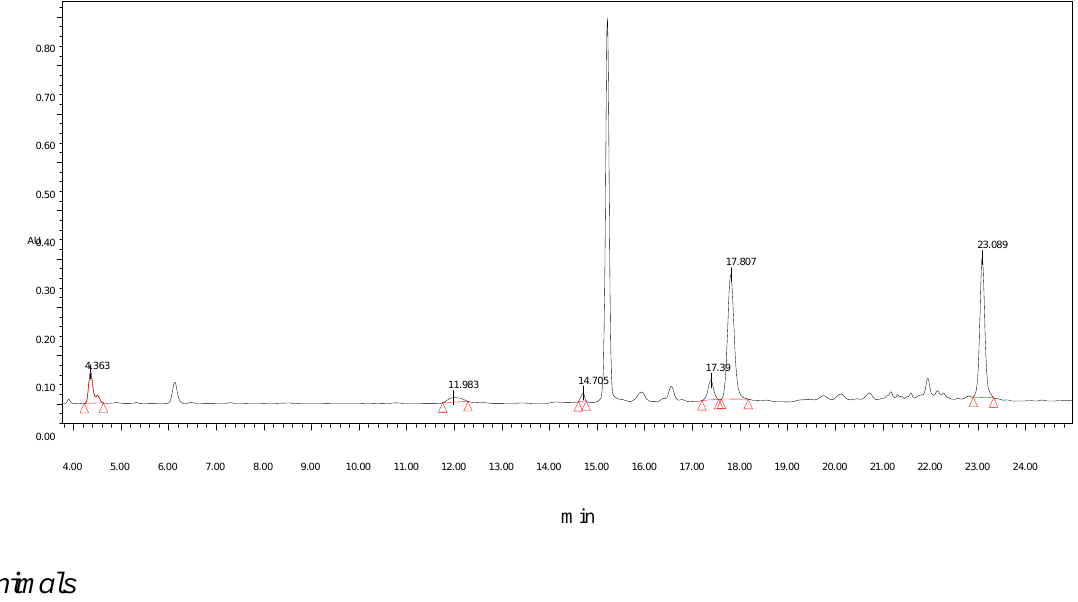
Figure 1. Chemical composition of tea